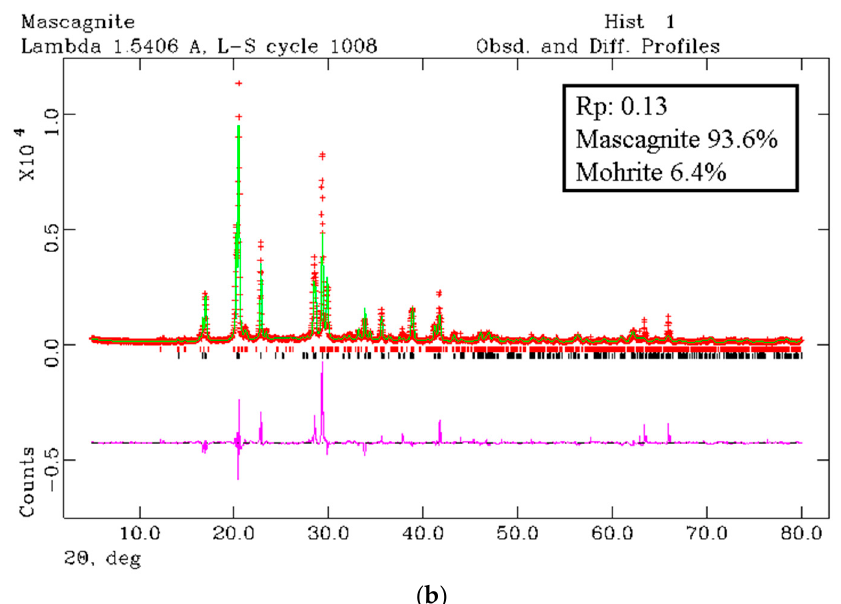
Figure 7. ( a ) Crystal structure of mascagnite projected along the x axis. In blue, the ammonium and in yellow, the sulfate tetrahedra are reported. The sticks are the NH...O hydrogen bonds. ( b ) The X-ray diffraction spectrum of the sample indicated as mascagnite refined with the Rietveld method [50], using GSAS EXPGUI [51,52] software.